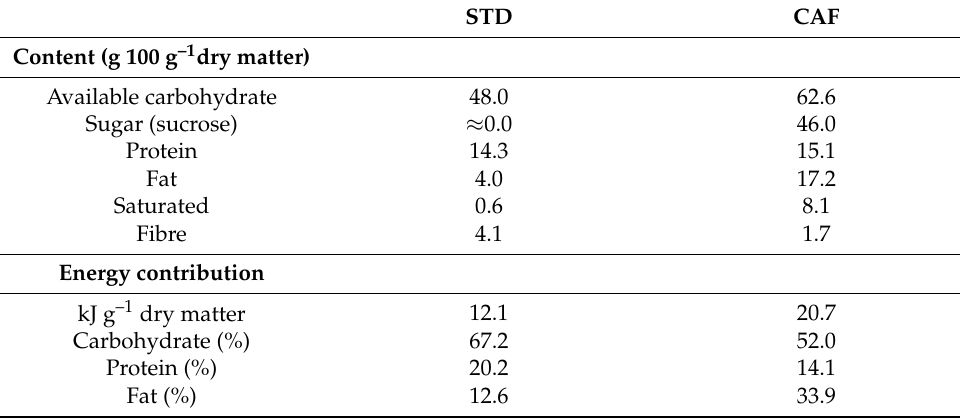
Table 1. The composition and energy content of diets administered.